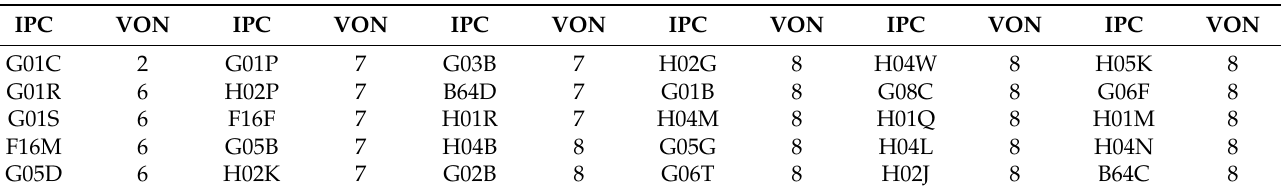
Figure 11. Visualization of the IPC/date matrix based on patents DJI applied for from 2010 to 2020. Table 2. IPCs and their value of technological